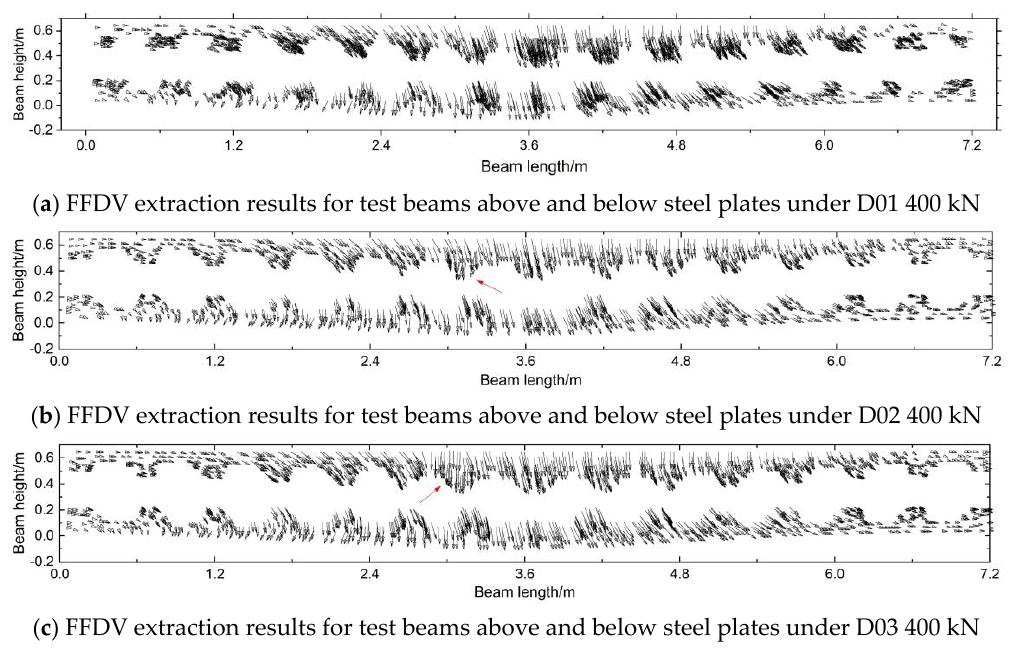
index for the structure’s FFDV. The FFDV above and below the steel plates was extracted based on 400 kN as an example, as shown in Figure 29.